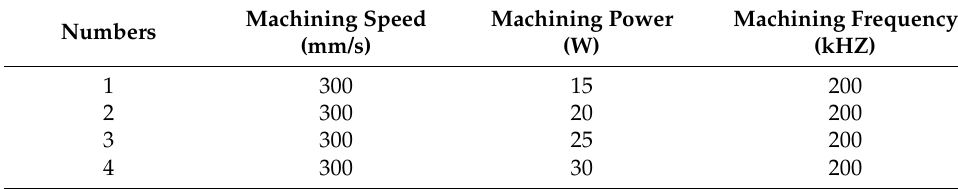
Table 4. Process parameters of laser processing—Power.